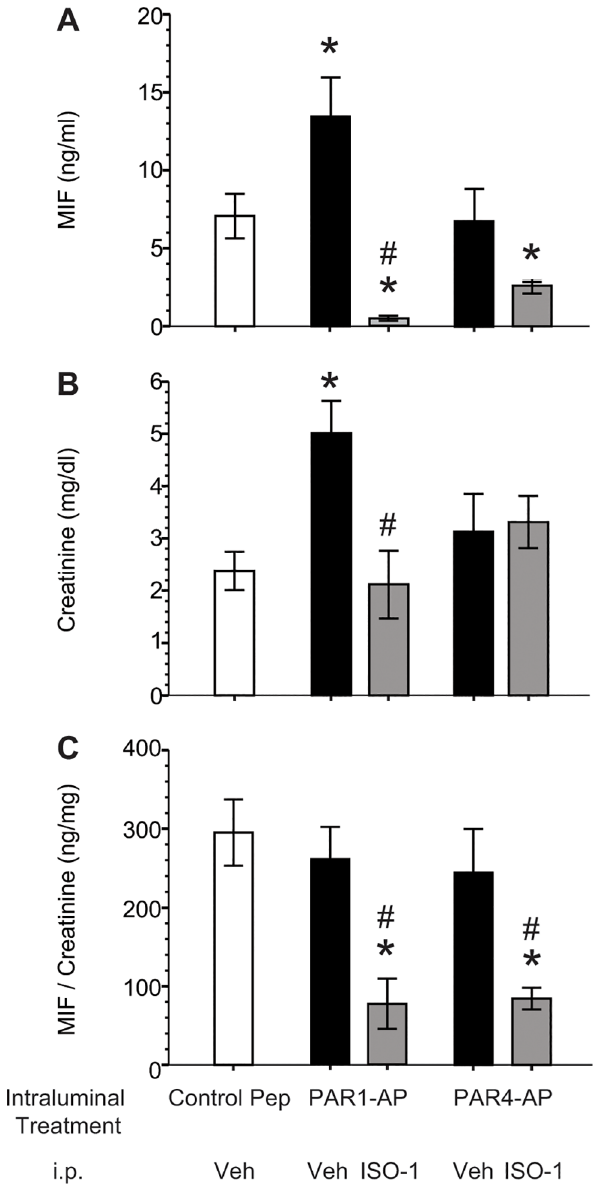
Fig 2. ELISA did not detect PAR1- or PAR4-evoked urothelial MIF release in vivo . Anesthetized female mice received intravesical instillation of a specific mouse PAR1 or PAR4 activating peptide or a scrambled peptide (control) for one hour. In addition, they received either MIF antagonist (ISO-1) or vehicle (20% DMSO) i.p. 15 minutes prior to intravesical instillation. The intraluminal fluid was collected and assayed for MIF by ELISA as previously described [11] and for creatinine concentration. A ) MIF concentration (pg/ml) in the intraluminal fluid was increased after PAR1, but not PAR4 stimulation, relative to control (scrambled) peptide stimulation. This effect was prevented by MIF inhibition through ISO-1 pre-treatment. ISO-1 also decreased MIF concentration in PAR4-AP treated animals as compared to controls. B ) Creatinine concentrations were higher in PAR1-AP treated animals but not in PAR4-AP treated animals. C ) When MIF concentrations were normalized to creatinine, PAR stimulation (with vehicle pre-treatment) did not show a difference when compared to controls (vehicle pre-treatment; scrambled peptide). ISO-1 pre-treatment significantly decreased ng MIF/mg Creatinine in either PAR1 or PAR4 treated groups. * p (cid:1) 0.05 compared to control group (vehicle pre-treatment; intravesical scrambled peptide); # p (cid:1) 0.05 compared to vehicle pre- treatment with respective PAR-AP.